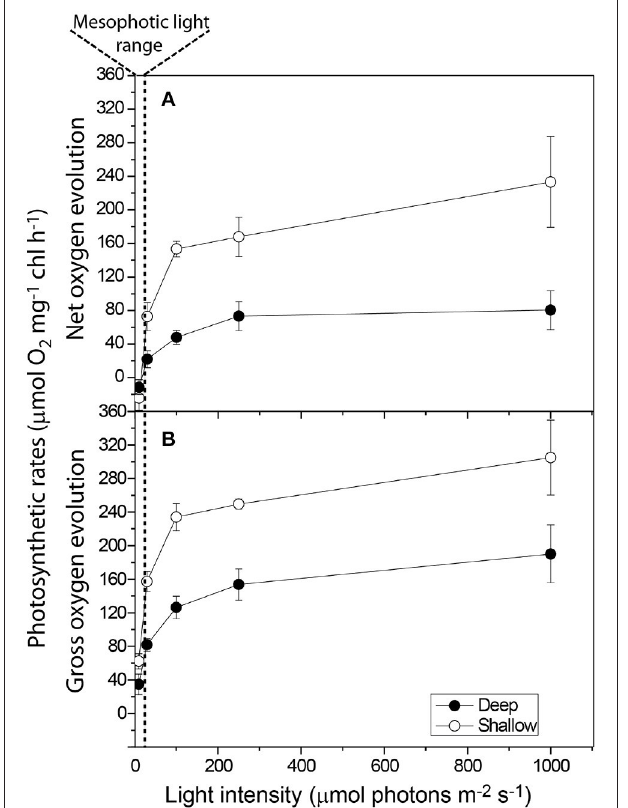
FIGURE 4 | Photosynthesis-Irradiance measurements of the initial mesophotic (65m) and shallow (3m) corals Symbiodinium sp. depicting (A) Net Photosynthesis and (B) Gross photosynthesis. Mesophotic symbionts do not experience dynamic photoinhibition at shallow light intensities.